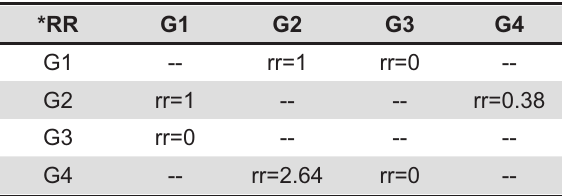
*rr=Relative Risk